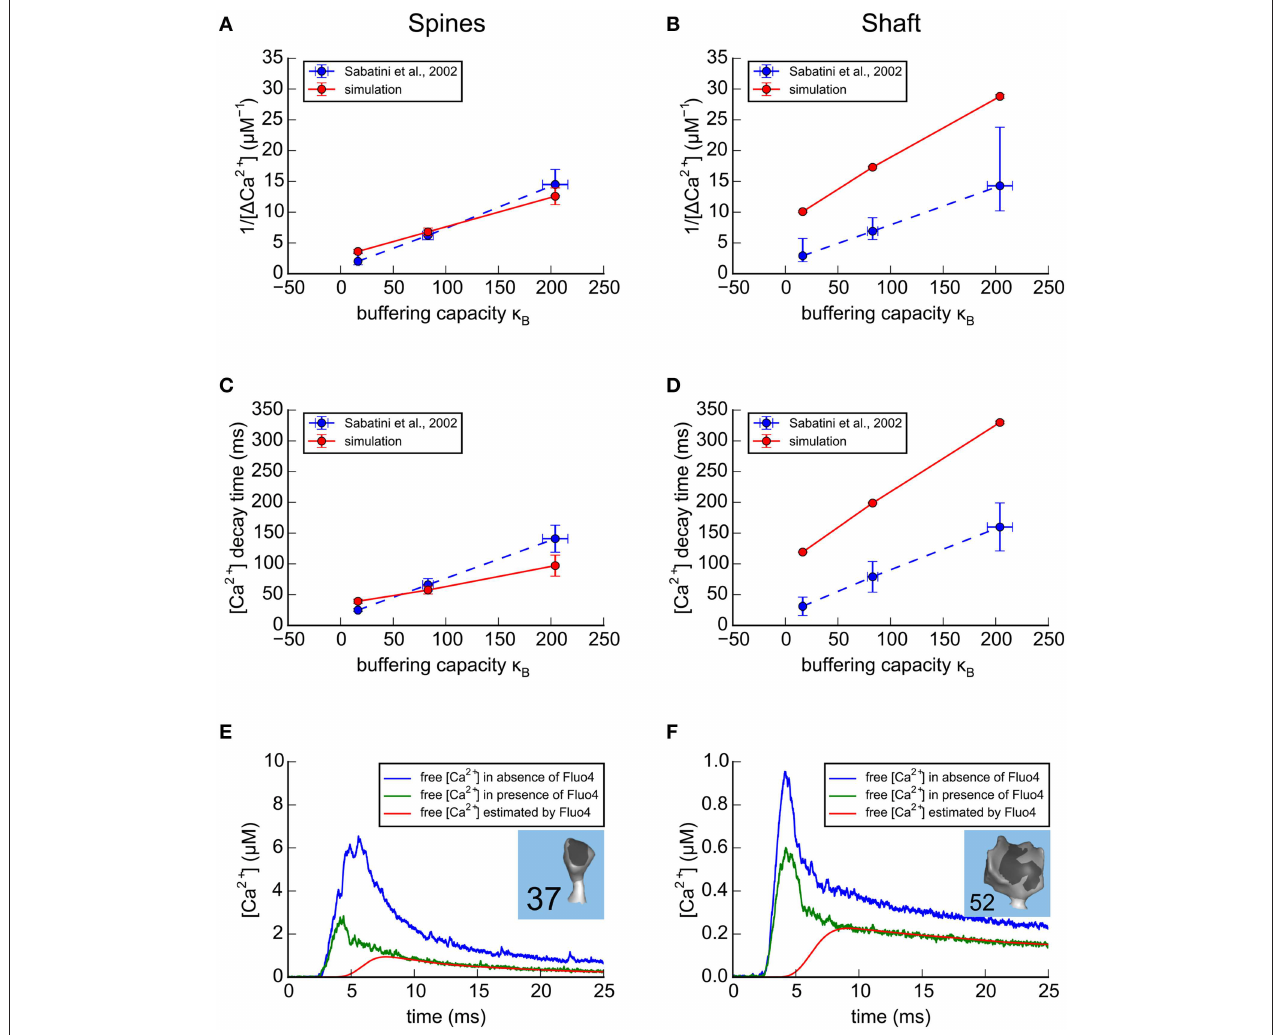
FIGURE 6 | Results of simulations in the spines and shafts of the large apical dendrite using parameters optimized for the small branch dendrite. (A–D) Simulation of Ca 2 + transients in response to a bAP in the absence of calbindin. As in Figure 5 , for comparison with experimental results of Sabatini et al. (2002; shown as blue dashed lines), concentrations of exogenous fluorescent Ca 2 + indicators in the model were set to 20 µ M Fluo4, 50 µ M OGB1, or 100 µ M OGB1. The simulated results in the large apical dendrite, averaged for the 13 spines with volumes ≥ 0.05 fl are shown as red lines. (A) For each concentration of indicator, the reciprocal of the averaged peaks of the Ca 2 + transients in the spines of the large apical dendrite, 1/ 1 [Ca 2 + ], is plotted against the buffering capacity in the presence of indicator ( κ B ) calculated as in Sabatini et al. (2002). The 1 [Ca 2 + ], extrapolated to zero indicator, was in the range 0.3–0.6 µ M (reciprocal of y-axis intercept) with κ e in the range 40–75 (x-axis intercept). (B) The reciprocal of the averaged peaks of the Ca 2 + transients in the dendritic shaft is plotted against buffering capacity. The 1 [Ca 2 + ], extrapolated to zero indicator, was 0.12 µ M with κ e = 75 . (C) The averaged time constant of Ca 2 + decay in the spines is plotted against Ca 2 + buffering capacity. The Ca 2 + decay time constant, extrapolated to zero indicator in the spines was 25 to 40ms (y-axis intercept) with κ e in the range 60–120 (x-axis intercept). (D) The averaged time constant of Ca 2 + decay in the dendritic shafts was plotted against buffering capacity. The Ca 2 + decay time constant, extrapolated to zero indicator in the dendritic shafts was 100ms with κ e = 80 . (E,F) Ca 2 + transients in two spines of the calibrated model, in response to a bAP. Simulations were run in the presence and absence of 20 µ M Fluo4 in a median size spine ( E , spine #37, average of 32 trials) and in a large-size spine ( F , spine #52, average of 59 trials). The average Ca 2 + transients that would be estimated from the fluorescence of 20 µ M Fluo4 are shown in red. The average Ca 2 + transients, measured in the simulation by counting actual free Ca 2 + , are shown in the presence of Fluo4 (green), and in its absence (blue).